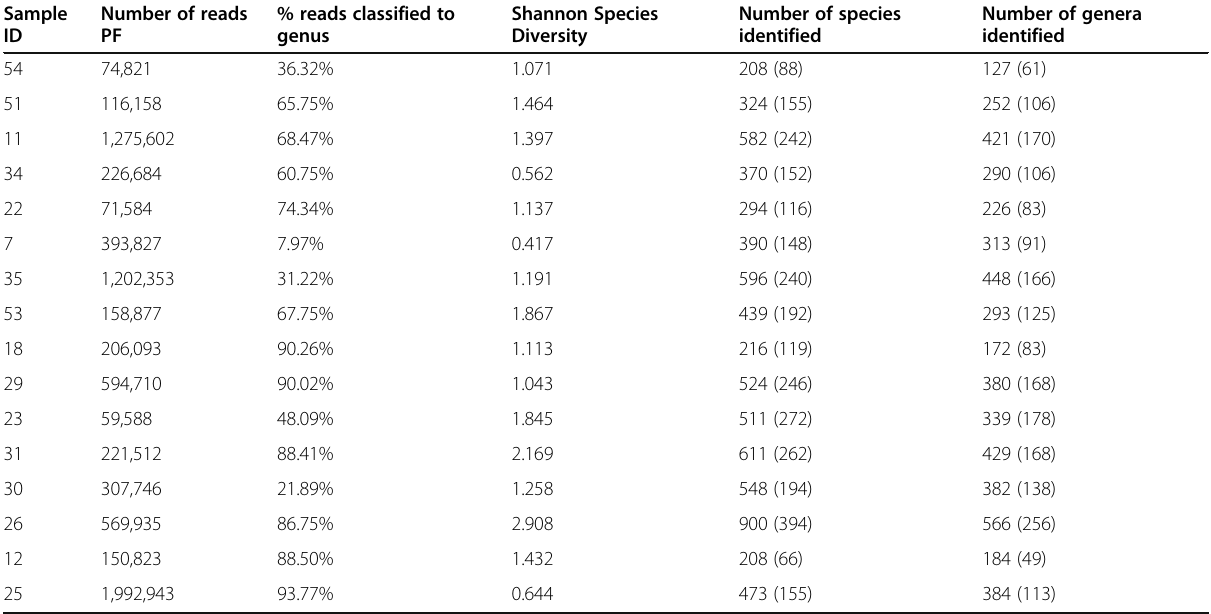
Table 3 Statistics of taxon identification obtained through BSSH and QIIME (in brackets). The Shannon Species Diversity Index is reported as a measure of species diversity in each sample. The QIIME analysis shows a reduced number of species and genera identified when compared to